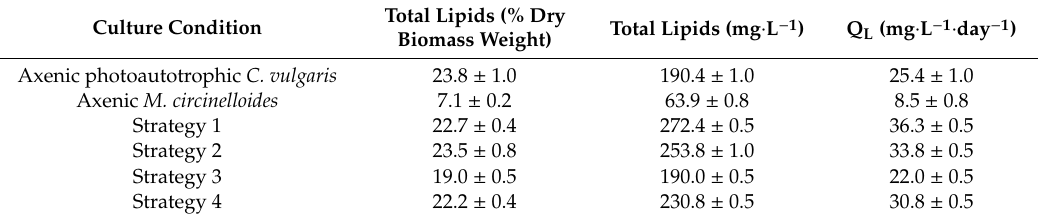
Table 1. Summary of lipid accumulation data from different culture strategies. 243